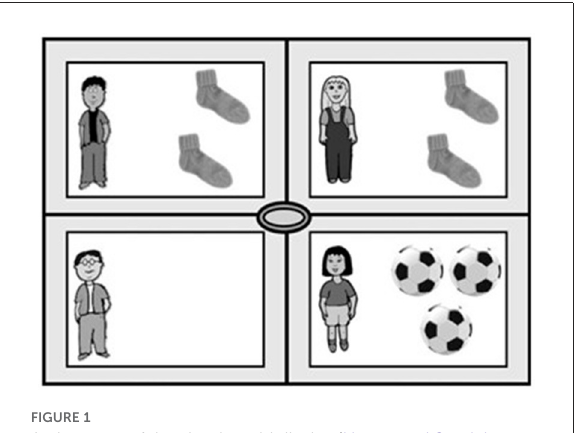
FIGURE1 An instance of the visual world display (Huang and Snedeker, 2009a, p.